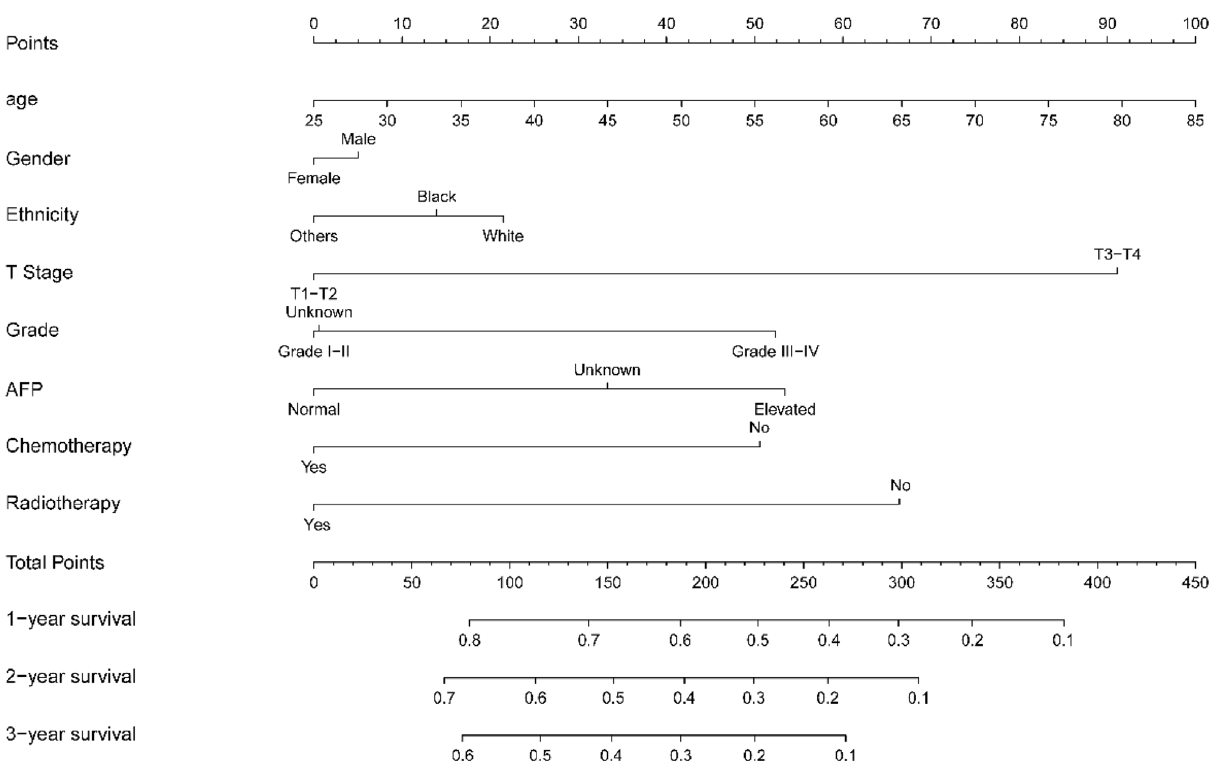
Figure 3. Nomogram constructed based on independent risk factors, as determined by multifactor Cox analysis. AFP